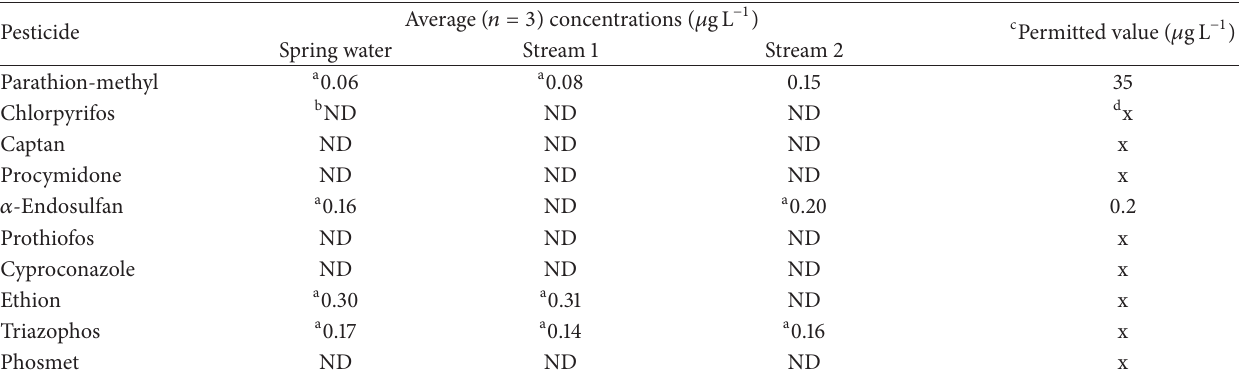
Presence of different class of pesticides. b Sample extraction of 72h. Table 4: Analyses of pesticides in real environmental water samples (spring water, stream 1, and stream 2).